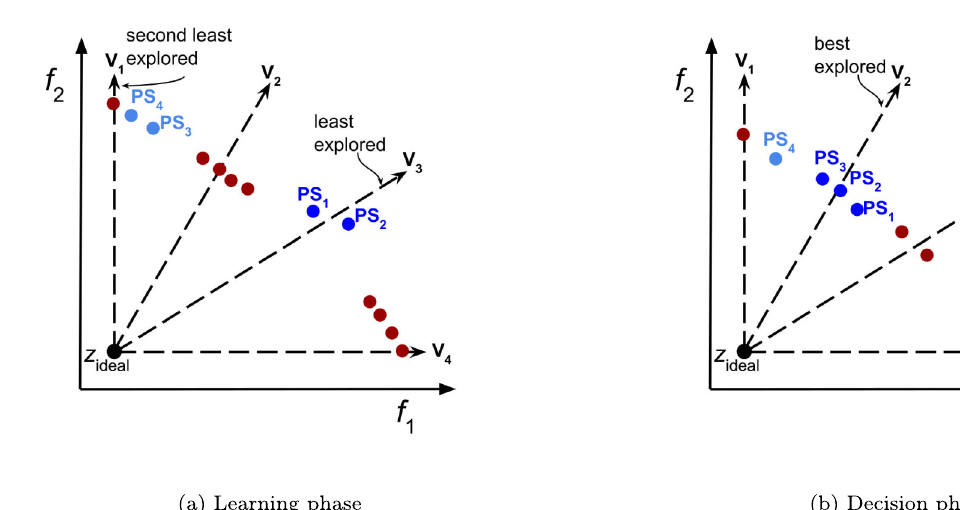
Fig. 3 Selecting the p most preferred solutions as preference information in